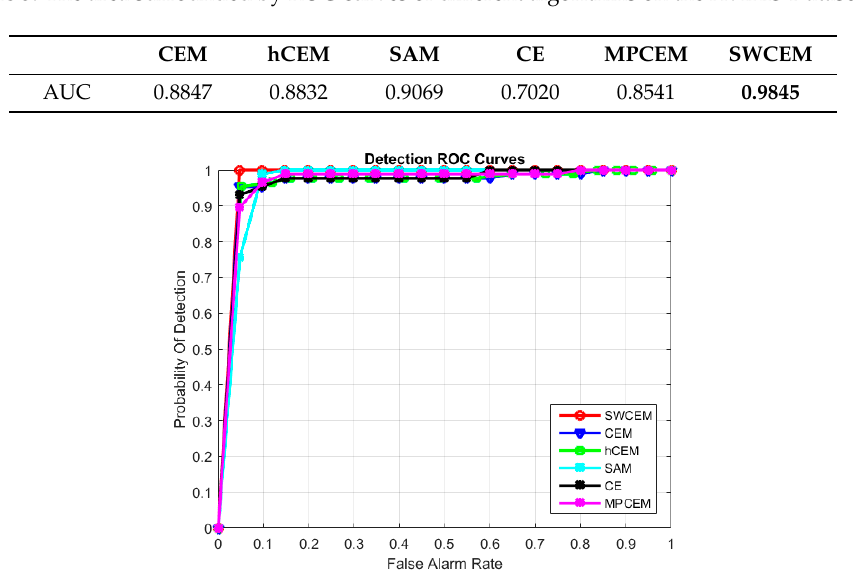
Table 5. The area surrounded by ROC curves of different algorithms on the AVIRIS Dataset 2.